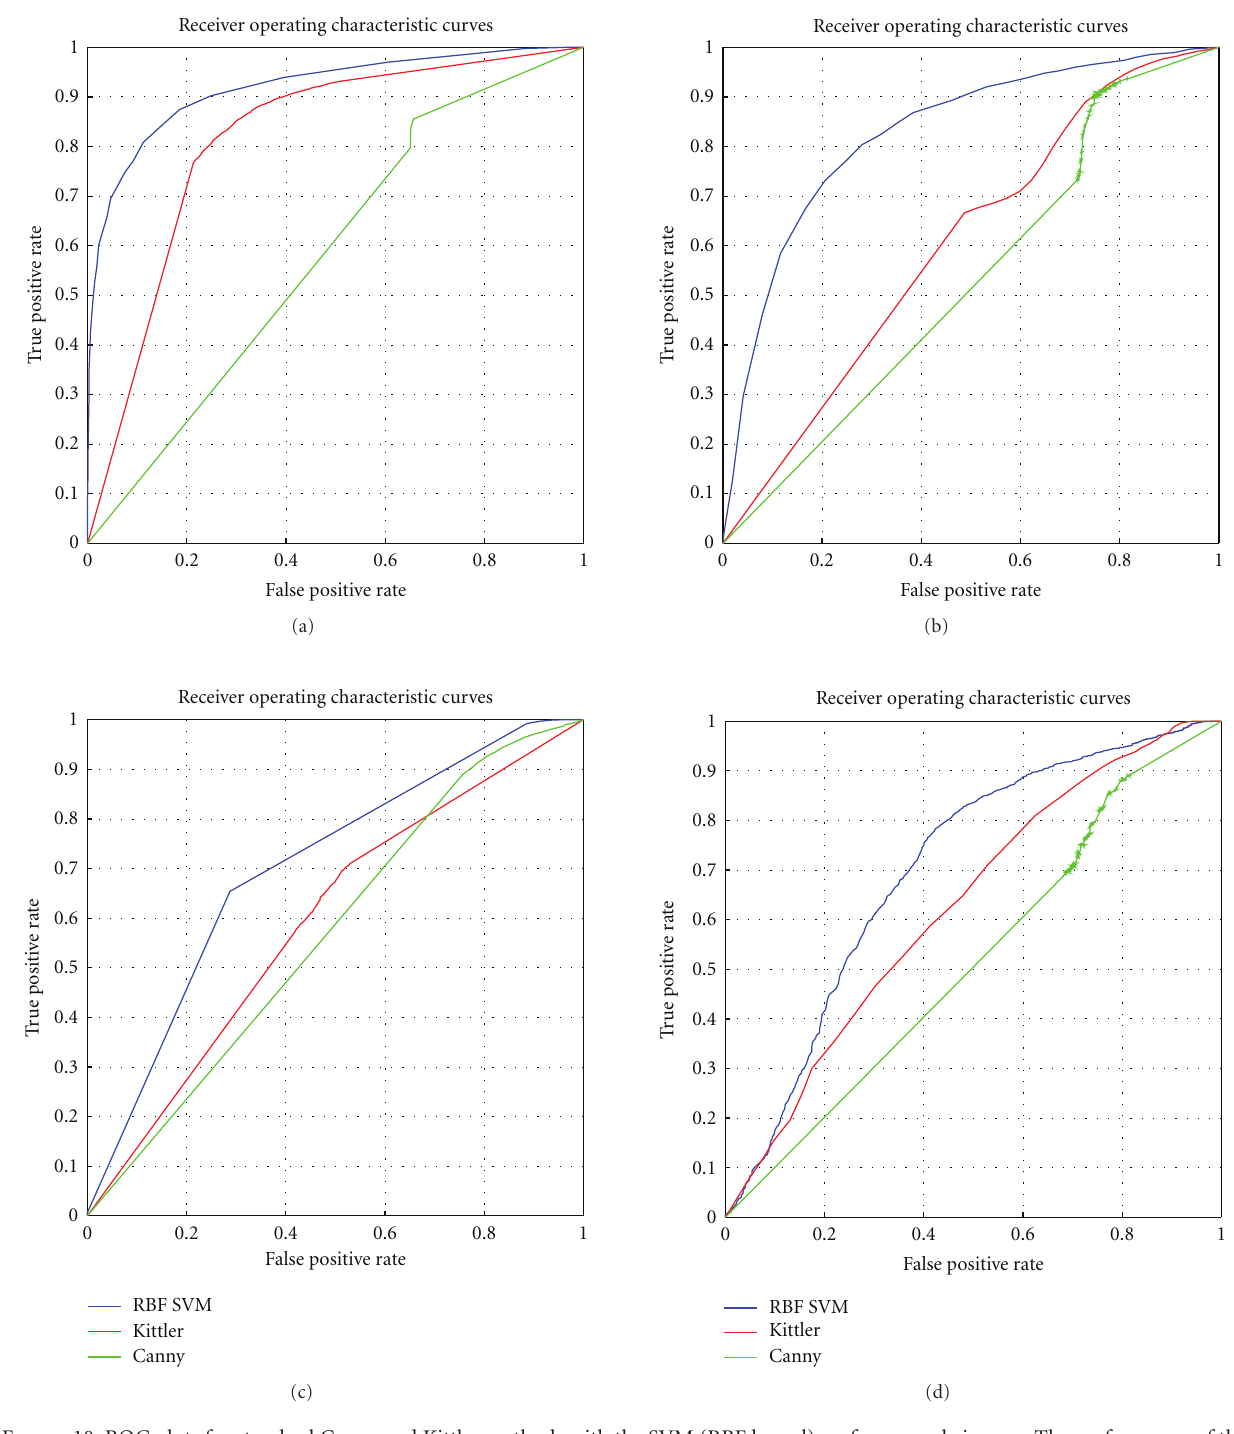
dominance patches of each candidate pixel in the image, and successfully segmented 43 out of 56 available regions to an acceptable level of accuracy. An adequate number of cells was characterised for further automatic morphological